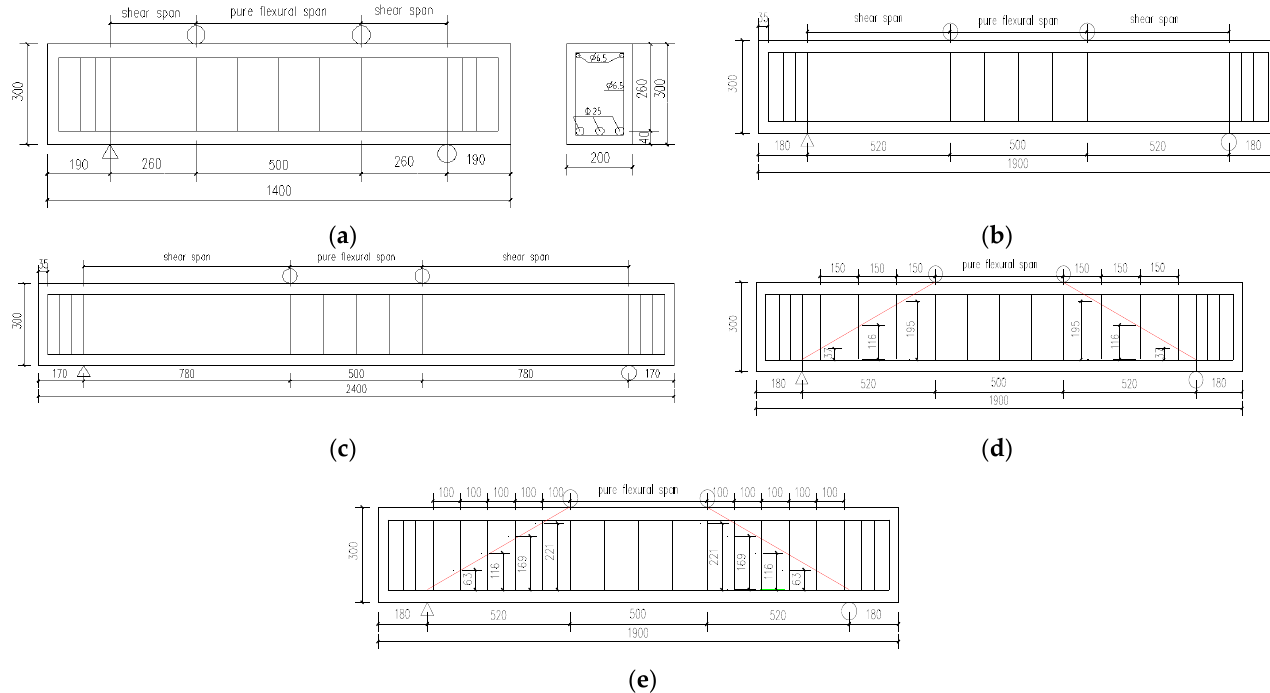
Figure 3. Reinforcement diagram of the test specimens (unit: mm). ( a ) λ = 1, ρ sv = 0. ( b ) λ = 2, ρ sv = 0. ( c ) λ = 3, ρ sv = 0. ( d ) λ = 2, ρ sv = 0.22%. ( e ) λ = 2, ρ sv = 0.33%.